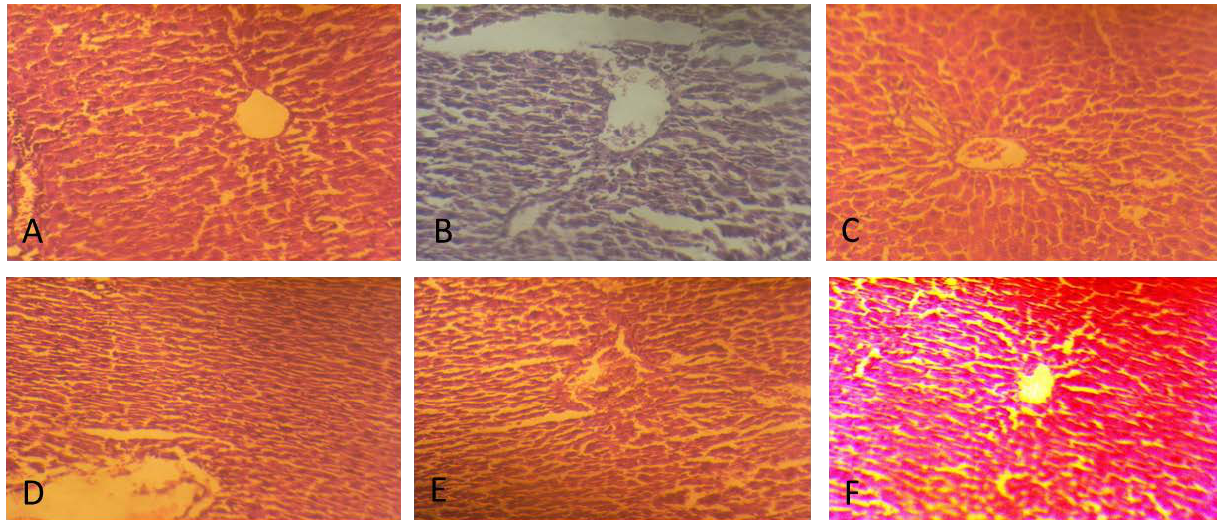
Fig. 1. Photomicrograph of the effect of administration of PEPP on the histology of the liver; (A) Normal control; (B) Hepatotoxic control; (C) Hepatotoxic treated with Silymarin; (D) Hepatotoxic treated with with 50 mg/kg b.w PEPP; (E) Hepatotoxic treated with 100 mg/kg b.w PEPP; (F)Hepatotoxic treated with 200 mg/kg b.w